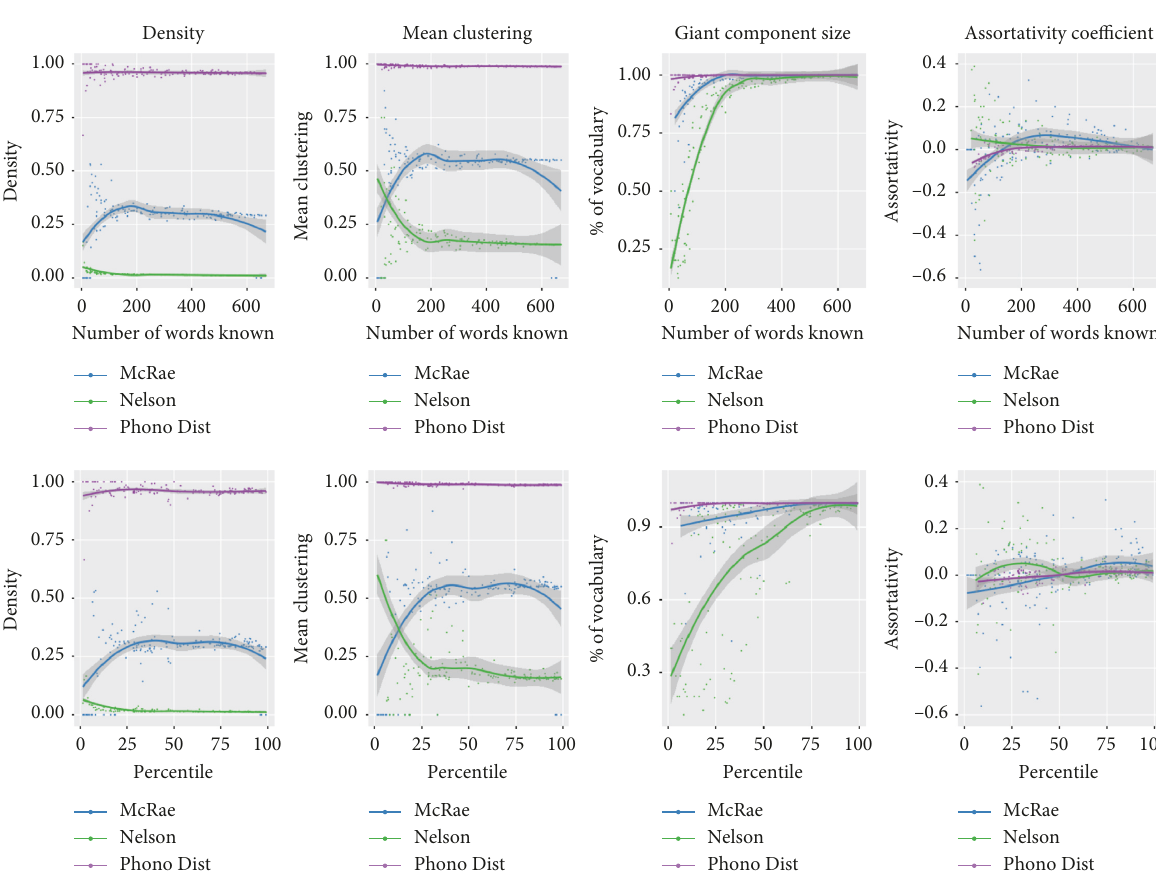
Figure 4: Plots of network measures as a function of the child’s vocabulary size (top) or percentile (bottom) for validation snapshots. Different network representations (colored) indicate that the snapshot structure varies over the course of development and dependent on language